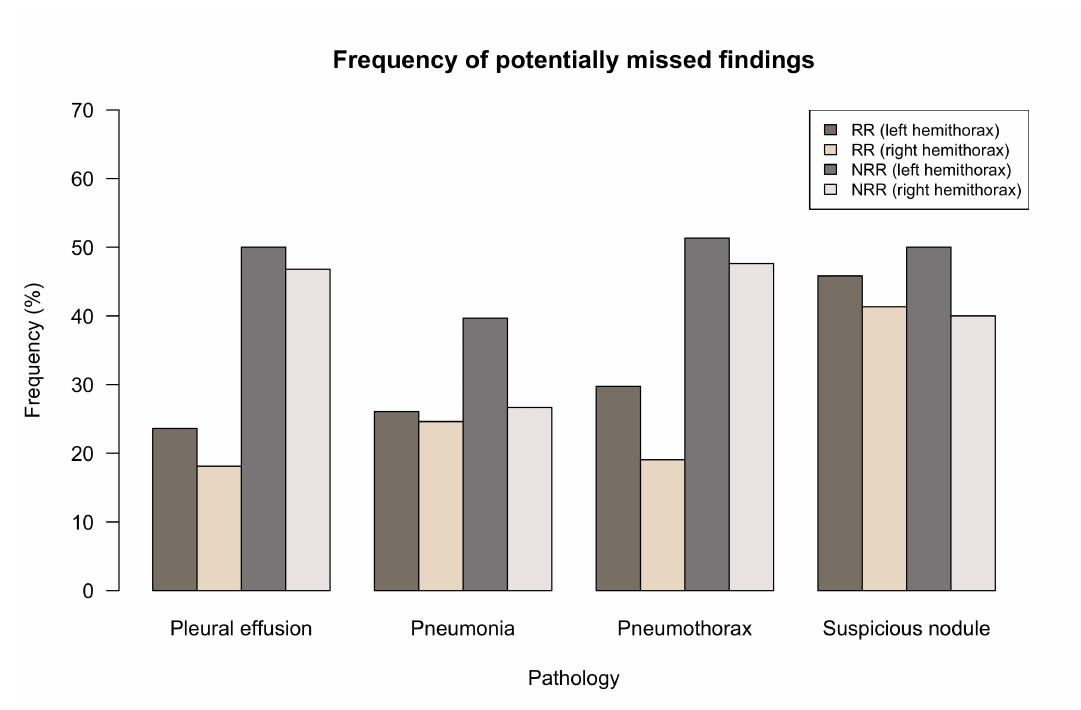
Figure 3. Potentially missed findings—Comparison of BCR consensus (serving as underlying reference standard) with RR and NRR. The graph shows the fraction of all cases in which the RR-/NRR-consensus were exactly 0 (consensus being defined as the sum of the groups’ three individual reading choices with a value range from 0–12) as a percentage of all cases with the BCR consensus exceeding 0. It therefore shows the fraction of cases that were potentially missed by all RR/NRR groups’ individual